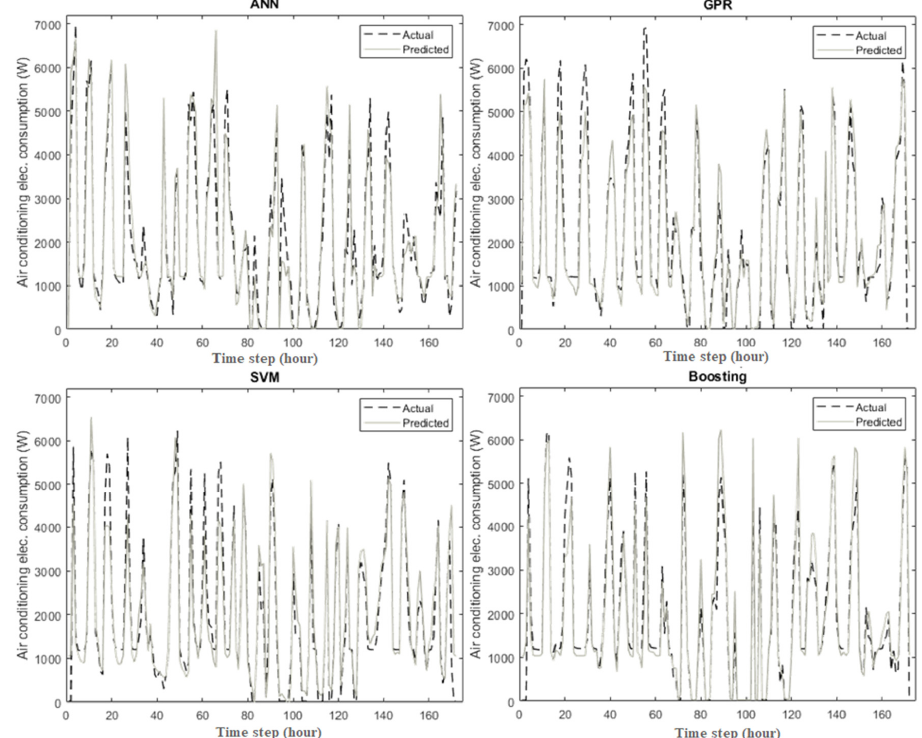
Figure 7. Measured and predicted air conditioning electrical consumption of mid-August to mid-September (validation set).